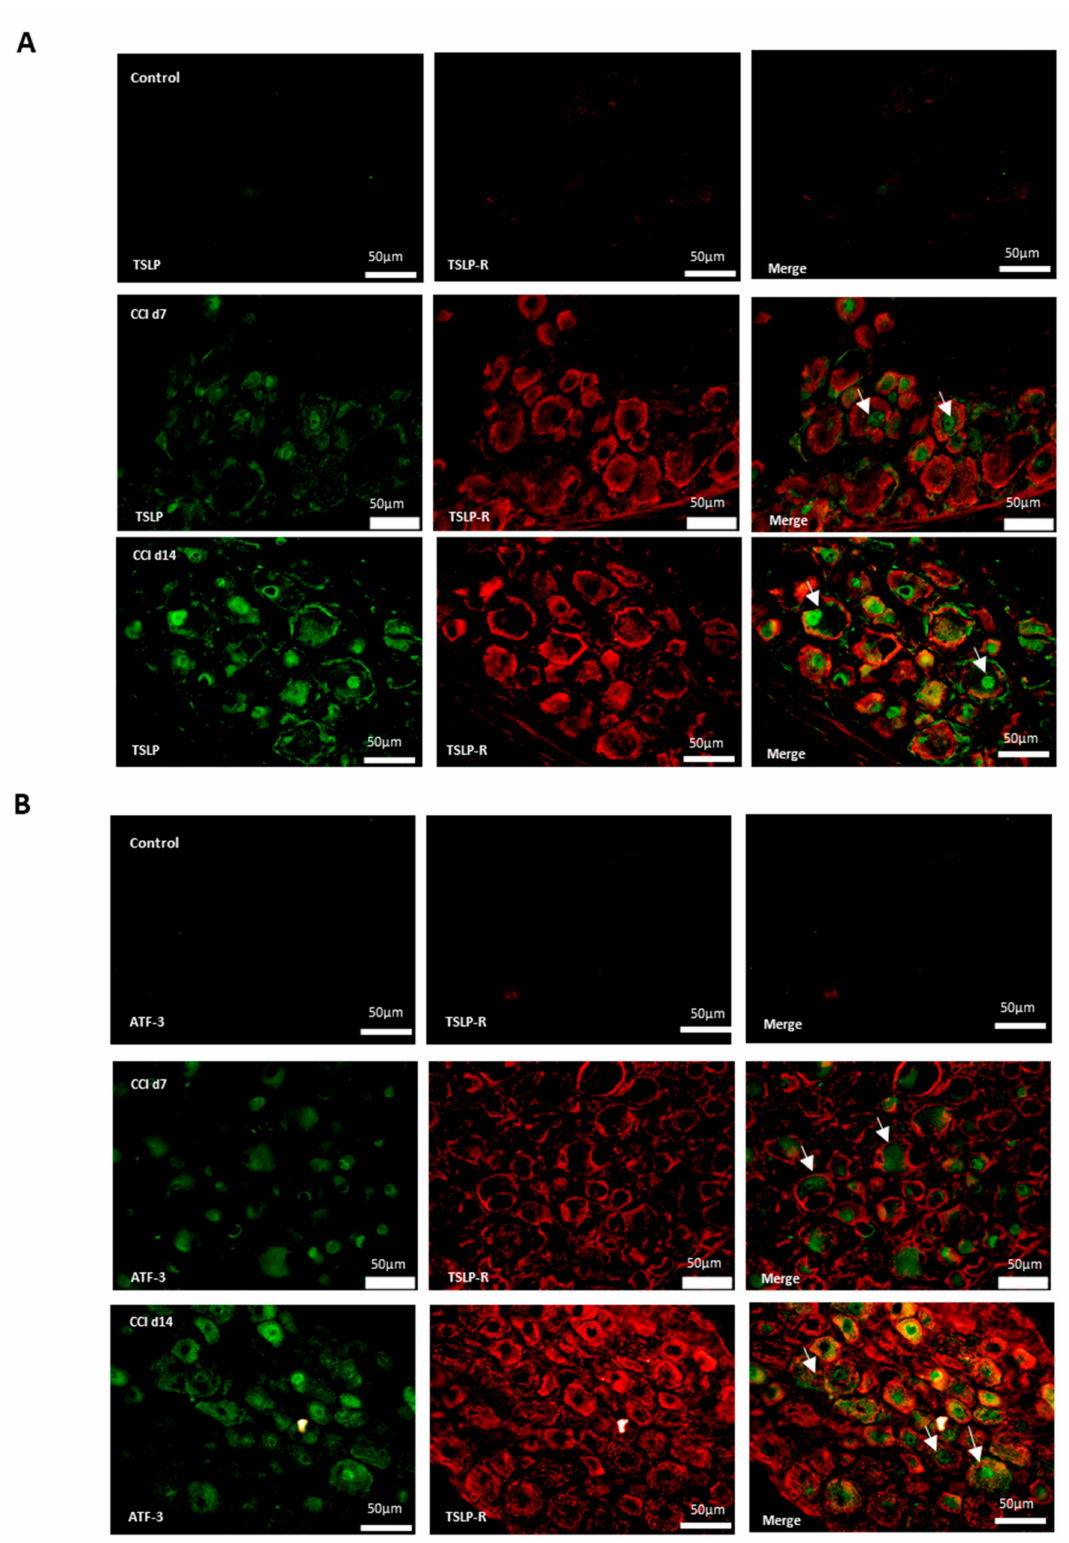
Figure 2. TSLP receptor expressed in injured DRG neurons. Double-labeled immunofluorescence imaging was performed in L4/5 DRGs of rats at 7 days and 14 days after CCI. ( A ) Representative double immunofluorescence labelling for TSLP (green) with TSLPR (red). Scale bar, 50 µ m. ( B ) Representative double immunofluorescence labelling results for TSLPR (red) with ATF-3 (green). Scale bar, 50 µ m. Pairs of images are merged. White arrows indicate double-labeled cells. N = 6 per